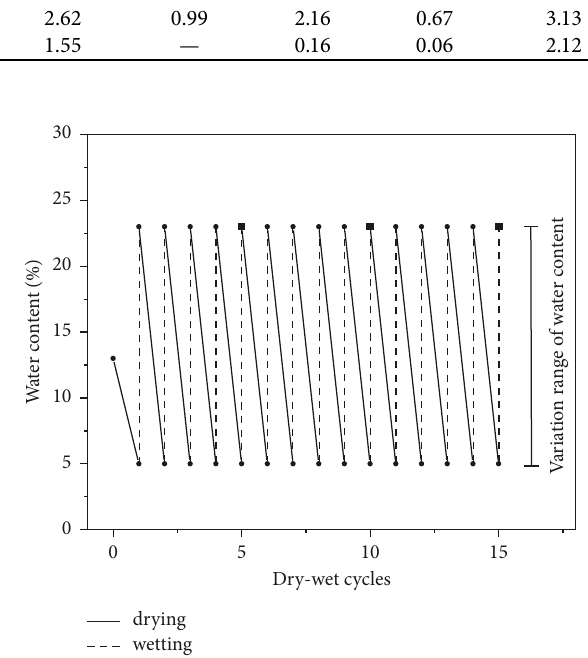
Figure 3: Changes in moisture content of sample during dry-wet